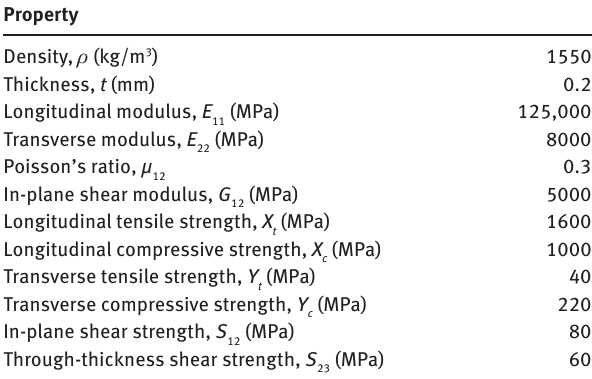
Table 1: Properties of T300/epoxy material.